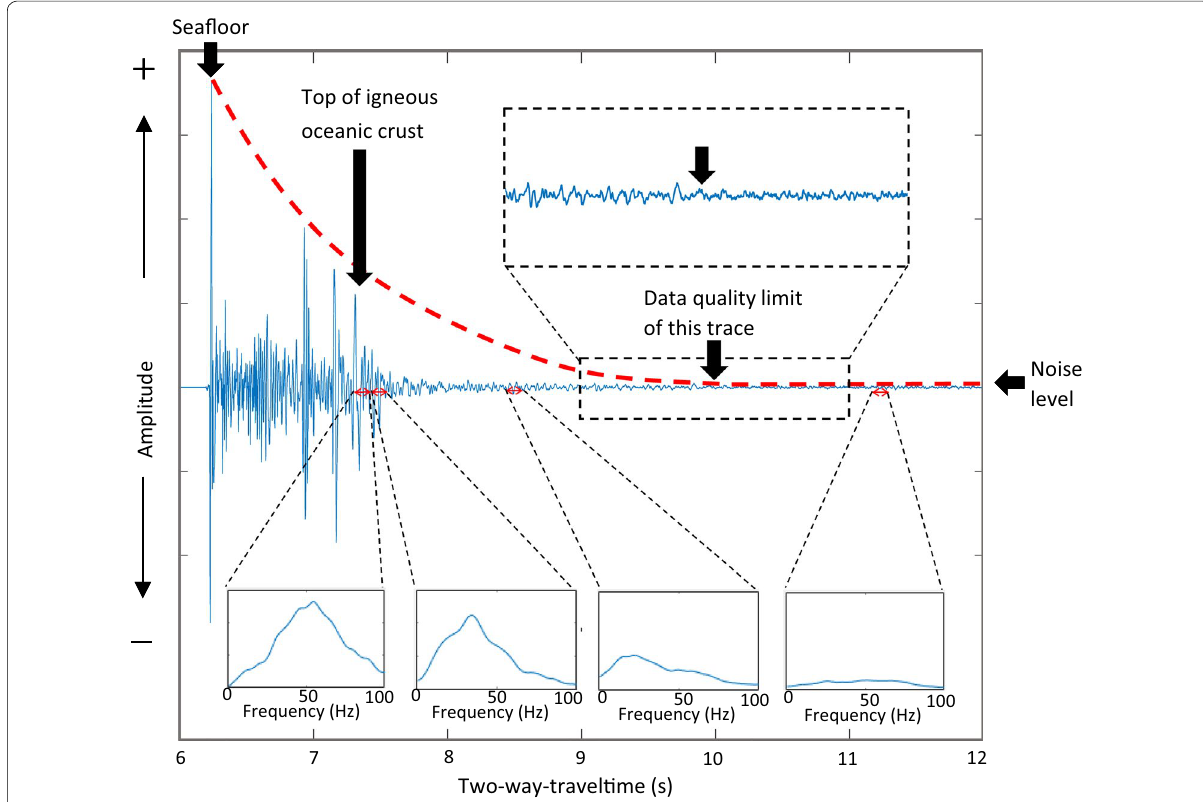
Fig. 3 Amplitude decay curve of a representative trace. The representative trace was computed by averaging 11 traces from CDPs 24,000 to 24,010. The red broken line shows amplitude decay curve of the representative trace, whose amplitude has the maximum value at the seafloor, decreases with increasing travel time and reaches a flat noise level at around 10 s. Amplitude spectra were shown at several time windows, which enables us to understand attenuation effects in frequency domain and frequency contents of noise